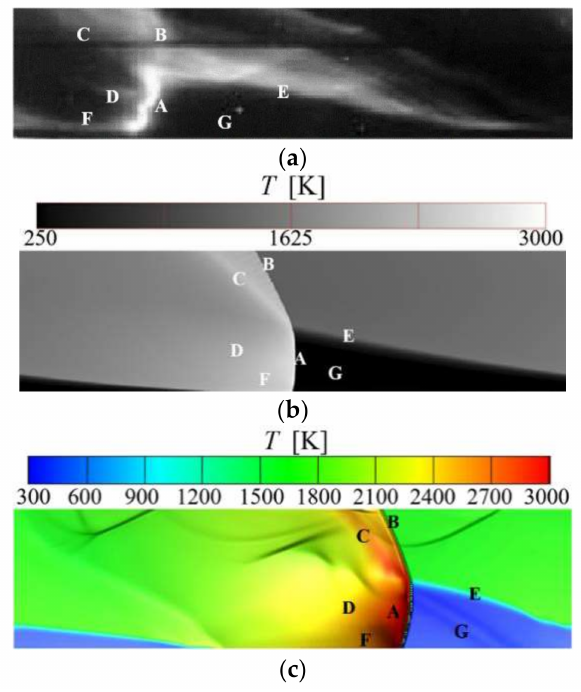
Figure 2. Comparisons of the results from ( a ) Bykovskii [36]; ( b ) Schwer; Reproduced with permission from [37], Elsevier, 2012; and ( c ) The present study.